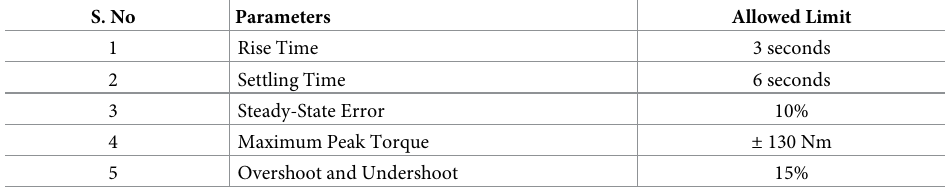
Table 2. Specification of the proposed control system. S. No